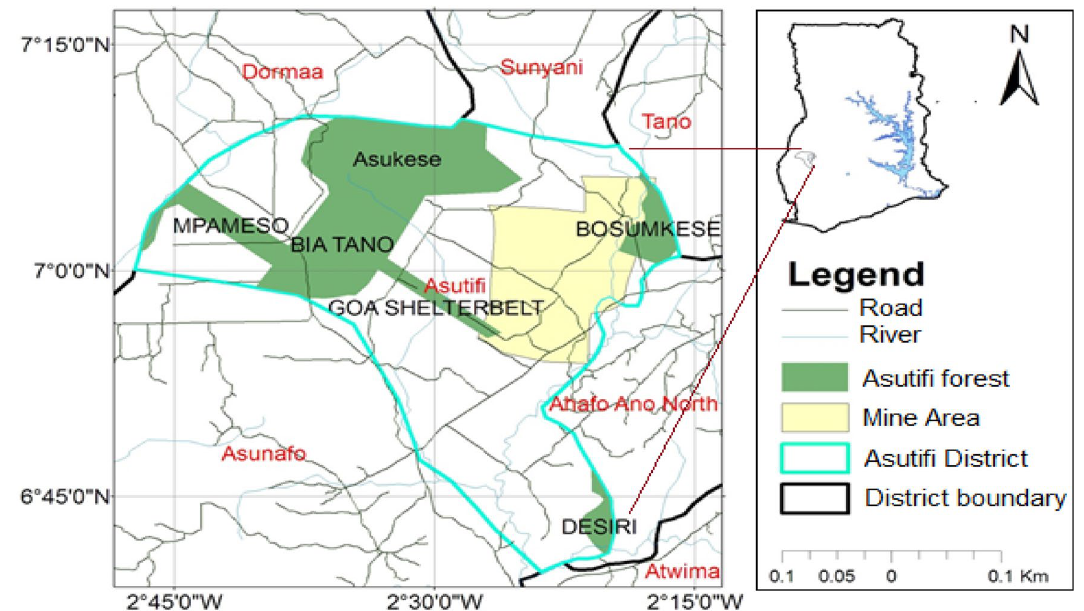
Fig. 1 Location and land-use map of Asutifi-North